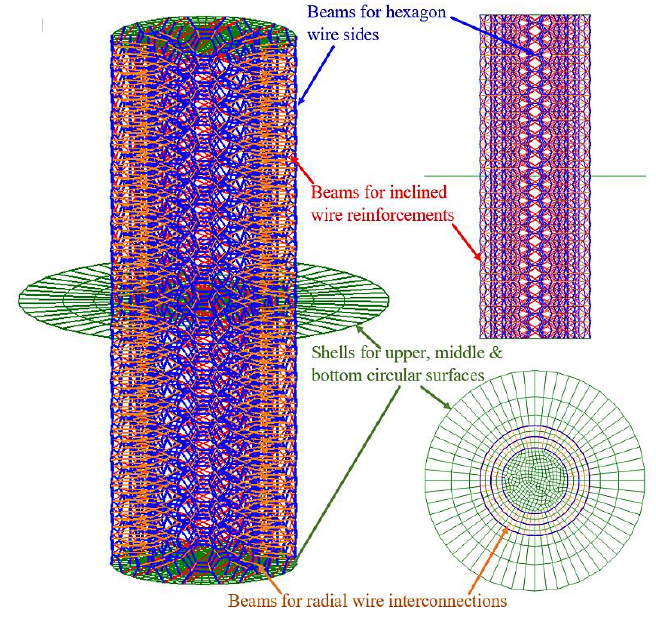
Figure 5. Discretized joint with beam and shell 3D finite elements.